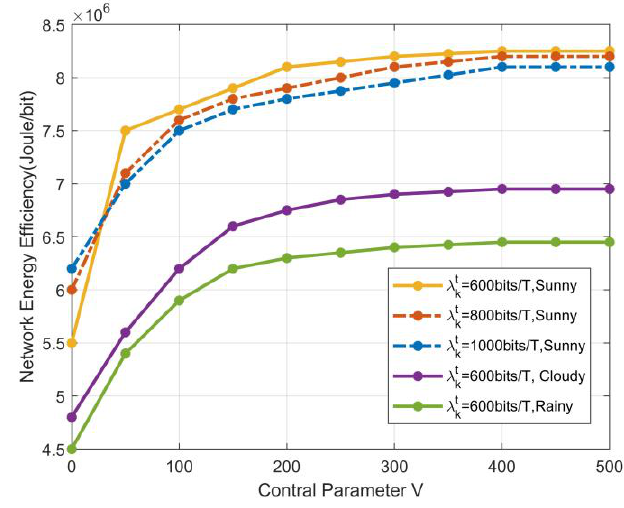
Figure 5. System energy efficiency vs. control parameter V.